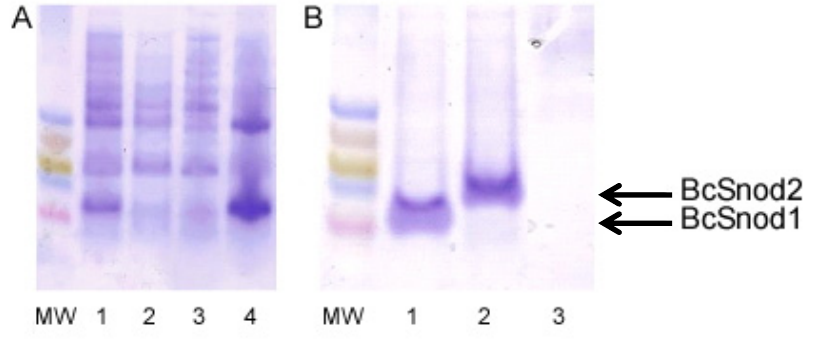
Figure 1. Bacterial expressed and purified BcSnods. A. Lane 0, Molecular Weight Marker; Lane 1, induced BcSnod1; Lane 2, uninduced BcSnod1; Lane 3, total soluble lysate; Lane 4, total insoluble pellet. B. Lane 0, Molecular Weight Marker; Lanes 1, 2 and 3 contain eluted fractions from metal chelation chromatography of refolded BcSnod1, BcSnod2, and vector-only control, respectively.